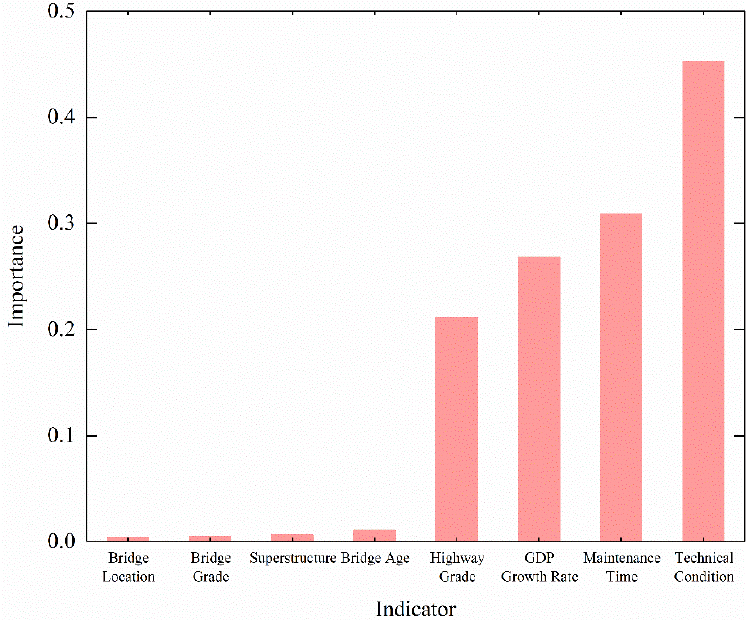
Figure 7. The calculation results of VIM of the main influencing factors.